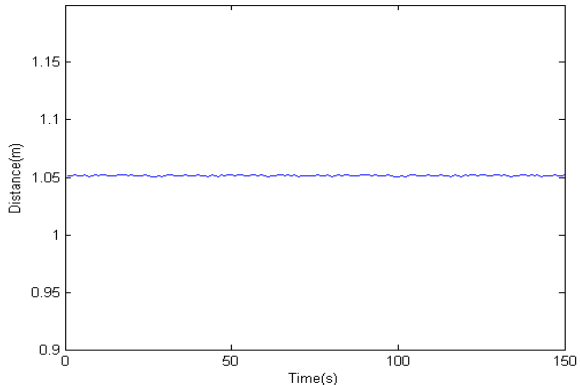
Figure 15. The distance to an obstacle obtained by binocular vision.